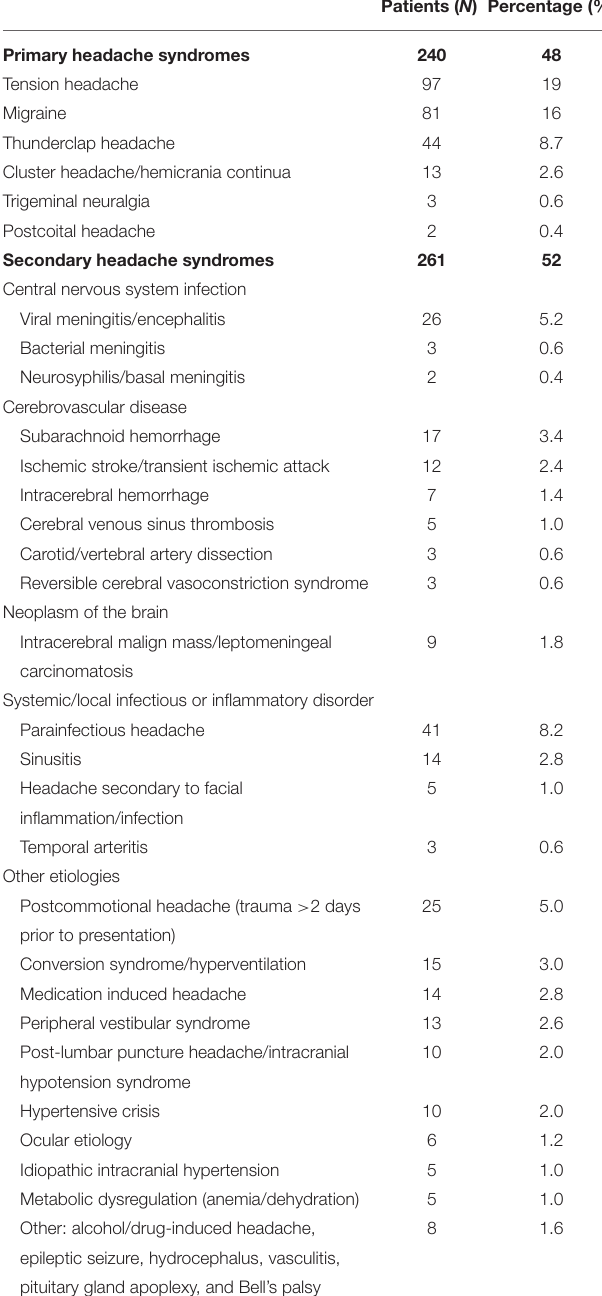
TABLE 1 | Clinical characteristics of patients and correlation to intracranial pathology on cranial CT.